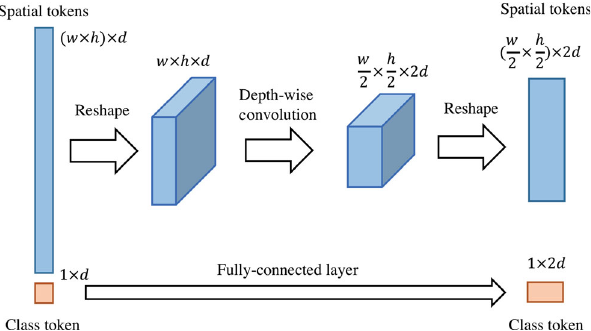
Fig. 6 Pooling layer in the PiT architecture. Reproduced with permission from Ref. [21], c (cid:2) The Author(s) 2021.